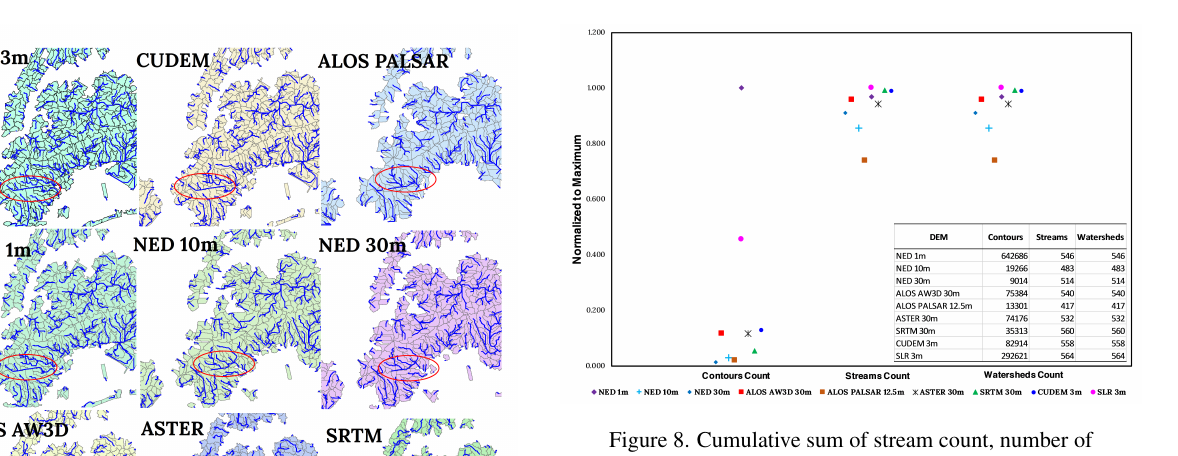
Figure 8. Cumulative sum of stream count, number of watersheds, and contour